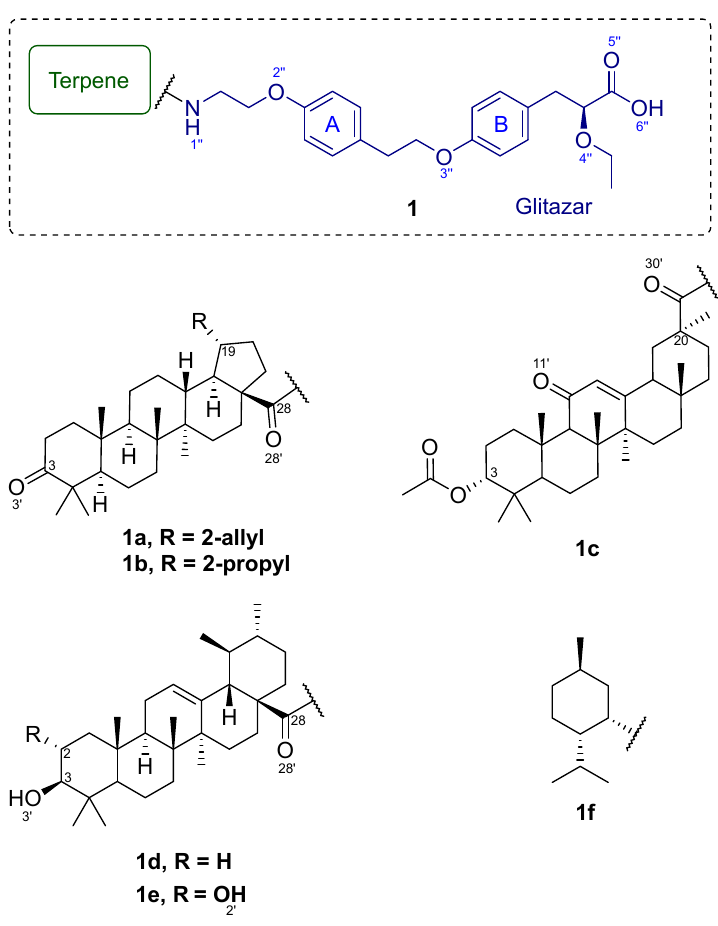
Figure 1. Triterpene amides ( 1a–e ) and neomenthylamine derivative ( 1f ).